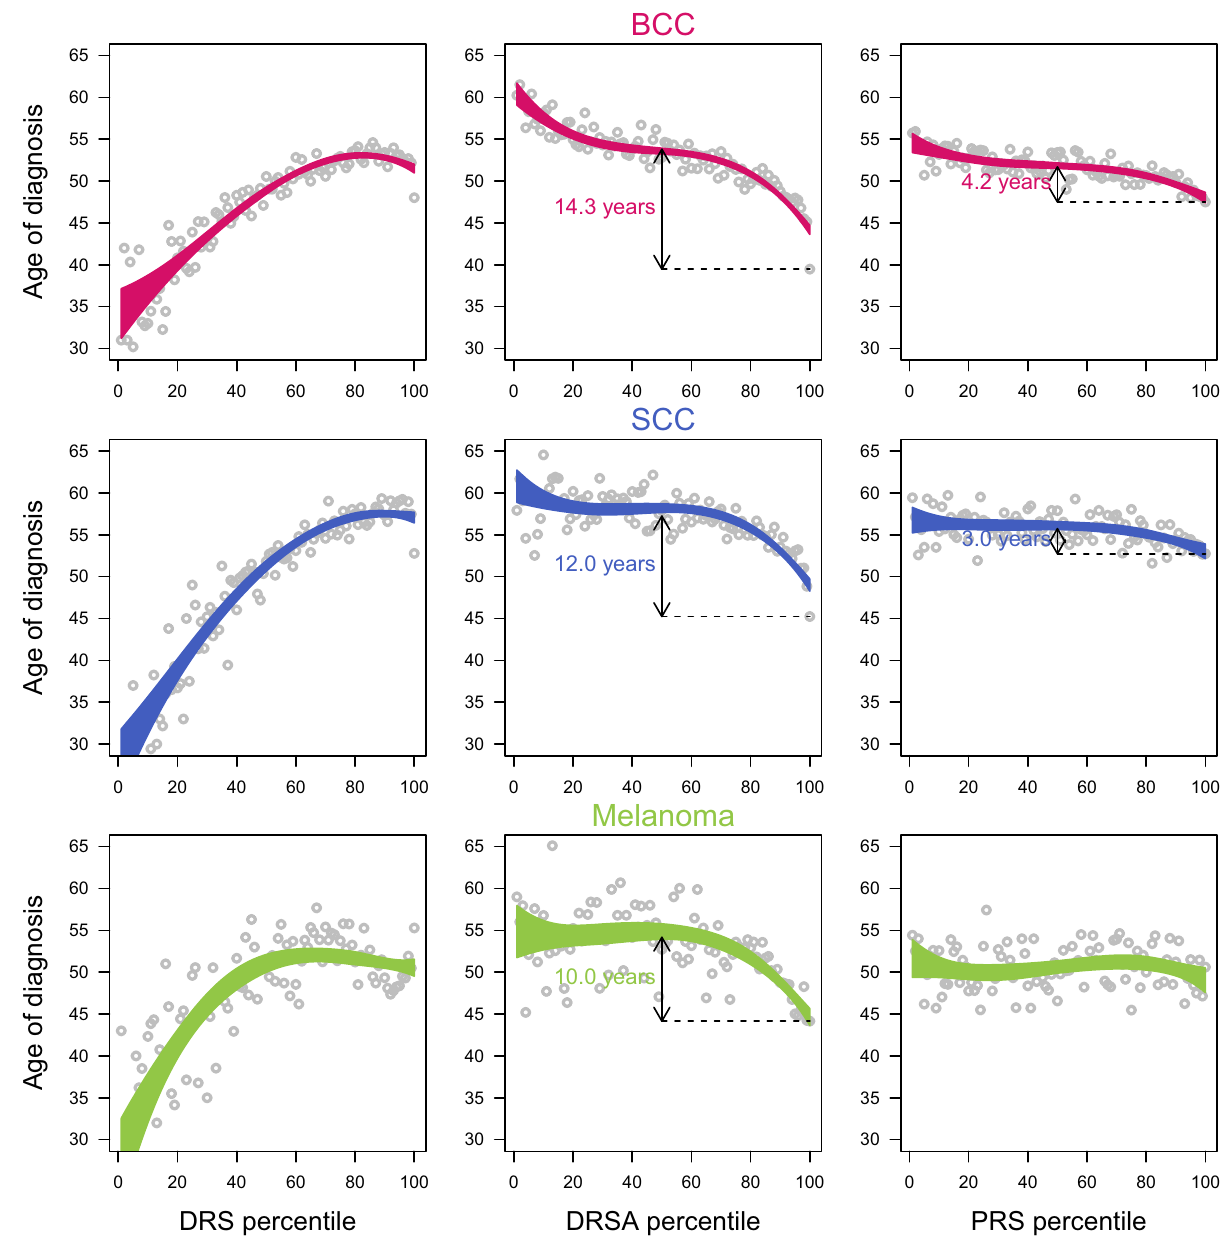
Fig. 4 Mean age of skin cancer diagnosis across the DRS, DRSA, and PRS distributions in the validation set. Risk score distributions are binned into percentiles. Each bin contains 890 participants. The dots are the mean age of diagnosis in each bin, and the area represents the 95% con fi dence interval of the mean age of